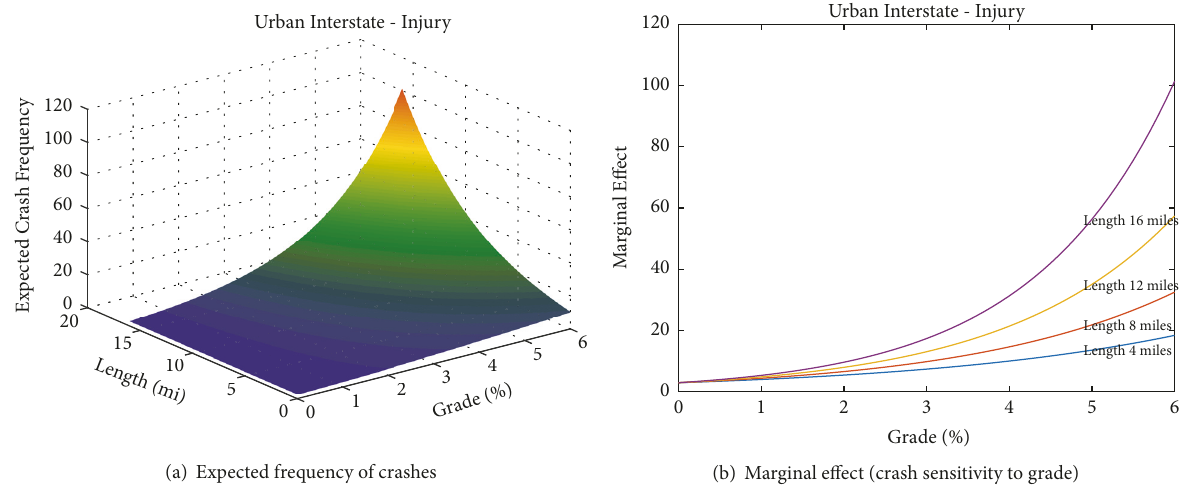
Figure 5: Urban interstate injury crashes.